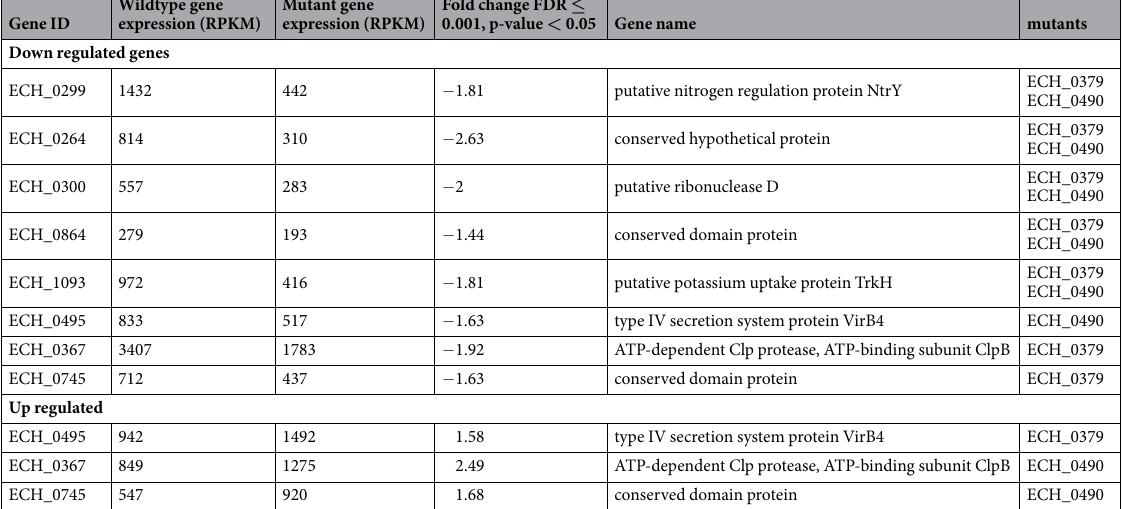
Table 5. E . chaffeensis common differentially transcribed genes in mutants.